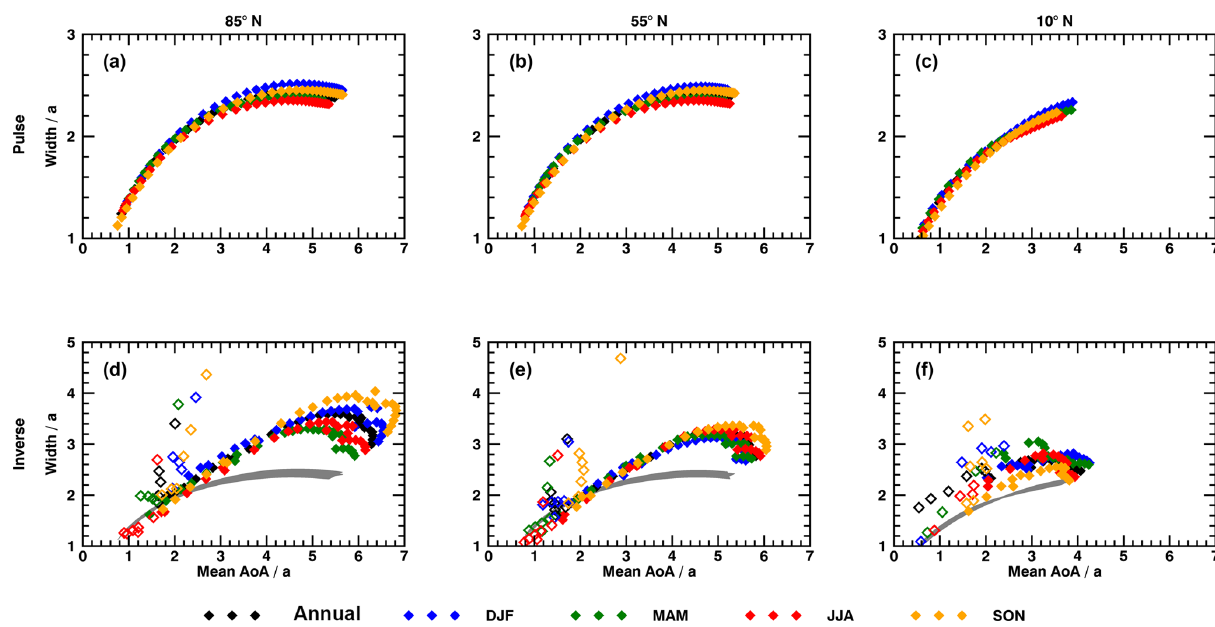
Figure 9. Vertical profiles of age spectra width as a function of their mean AoA at 85 ◦ N (a, d) , 55 ◦ N (b, e) and 10 ◦ N (c, f) . (a–c) show pulse spectra (Pulse) and (d–f) inverse method (Inverse). Seasons are given in colors. The unfilled diamonds denote data points that are found below the threshold of 1.5 years of clock mean AoA. Data of pulse spectra are also given as grey shading in (d–f) for better comparison.